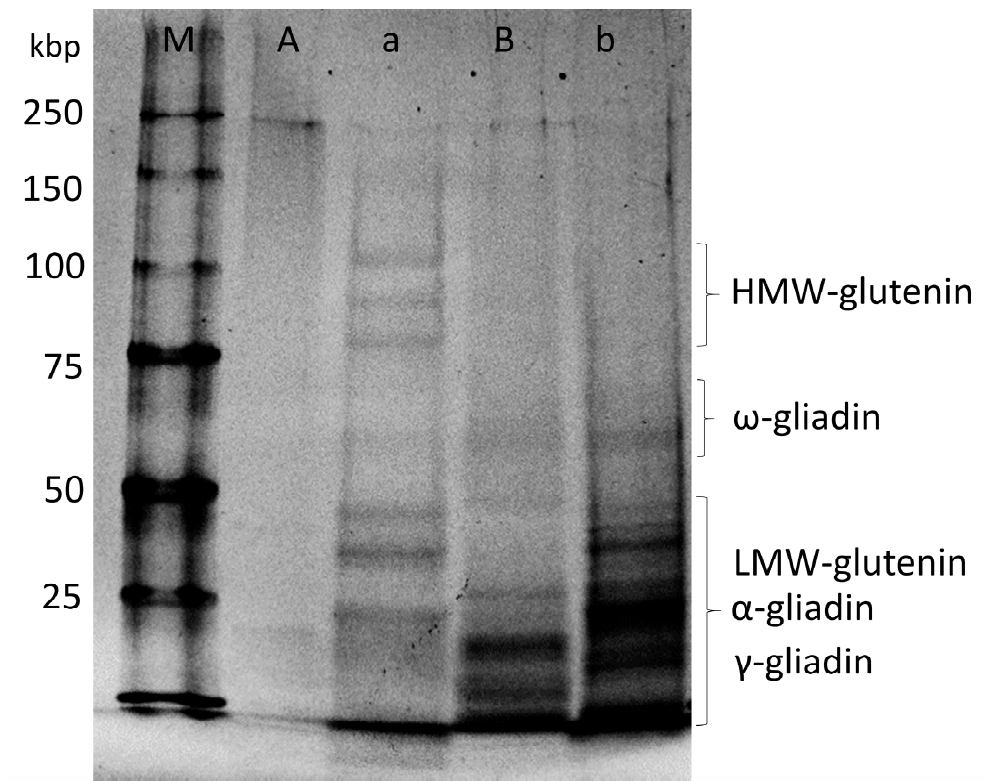
Figure 3. Electrophoretic images of SDS-PAGE for fractions A and B under nonreducing (A, B) and reducing (a, b) conditions. Fractions A and B are shown in Figure 2. The M lane is a size marker (from the top: 250, 150, 100, 75, 50, and 25 kbp).